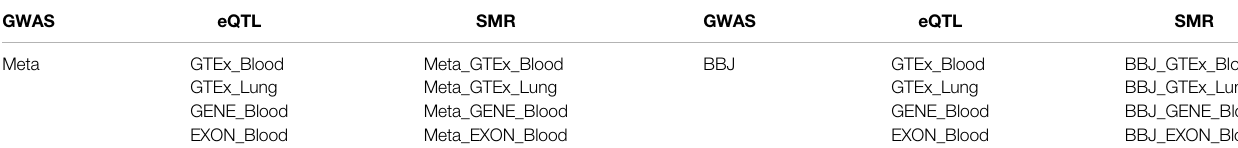
TABLE 1 | The new dataset list for SMR analysis. Eight SMR datasets were created for this analysis. GWAS